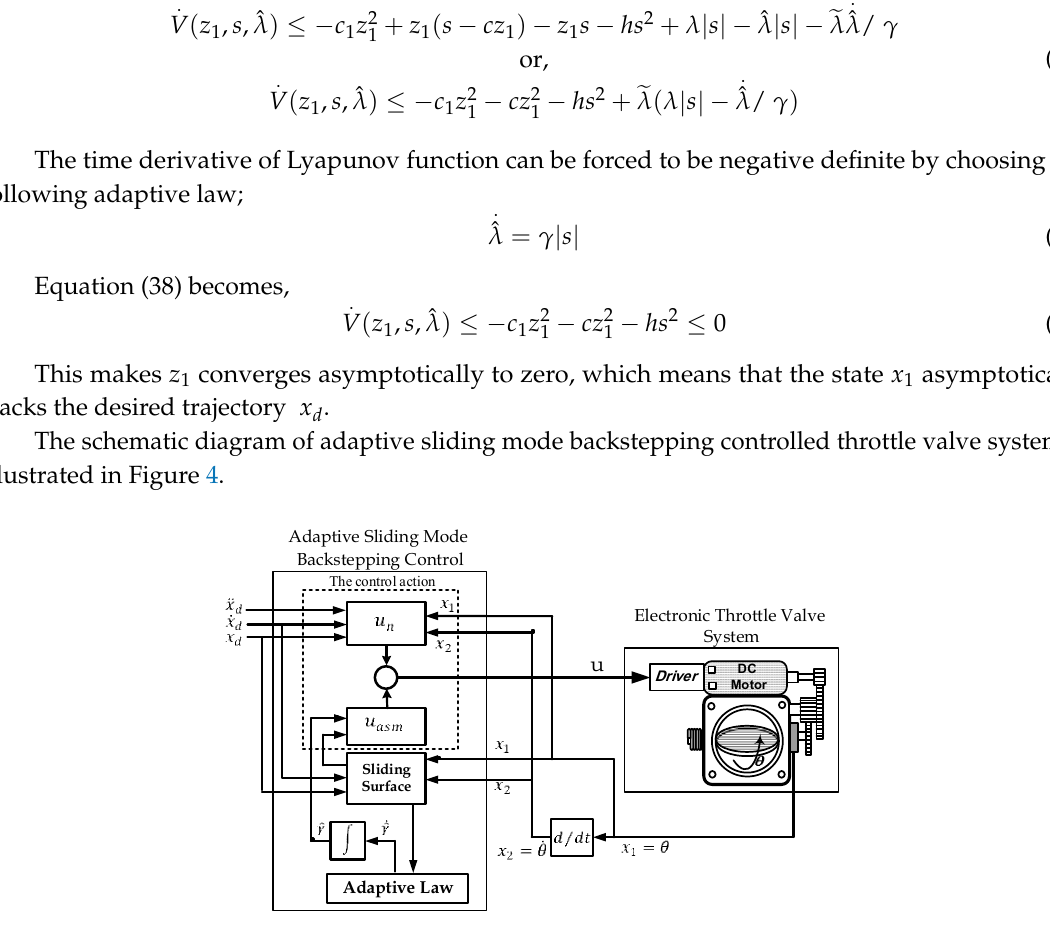
Figure 4. The schematic diagram of ETV system controlled by adaptive sliding mode backstepping controller.